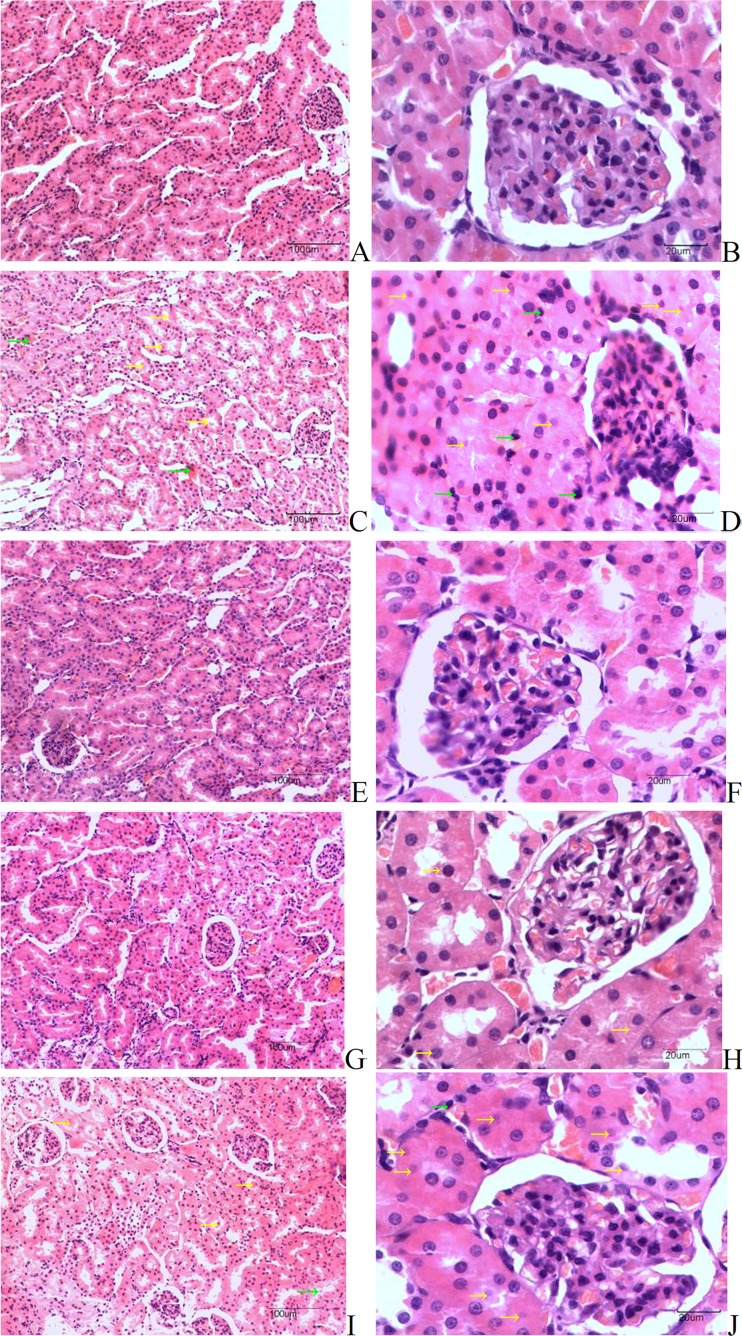
Changes in renal pathomorphology in rats (hematoxylin and eosin staining).
A,B, sham group;
C,D, shock group;
E,F, shock+drainage group;
G,H, shock+drainage+PPG group;
I,J, shock+drainage+NaHS group. PPG:
D,L-propargylglycine; NaHS: sodium hydrosulfide hydrate. Normal structure of
renal glomeruli and tubules in the sham group is shown in A
and B; protein casts (yellow arrows) and erythrocytes (green
arrows) were found in renal tubule lumens of rats in the shock and
shock+drainage+NaHS groups, as shown in Cand
I; tubular epithelial cells with necrosis (yellow arrows)
and karyopyknosis (green arrows) were observed in the shock and
shock+drainage+NaHS groups, as shown in D and
J; nearly normal architecture of glomeruli and tubules in
the shock+drainage and shock+drainage+PPG groups is shown in
E, F, G, and
H, plus mild edema of tubular epithelial cells (yellow
arrows) in H.